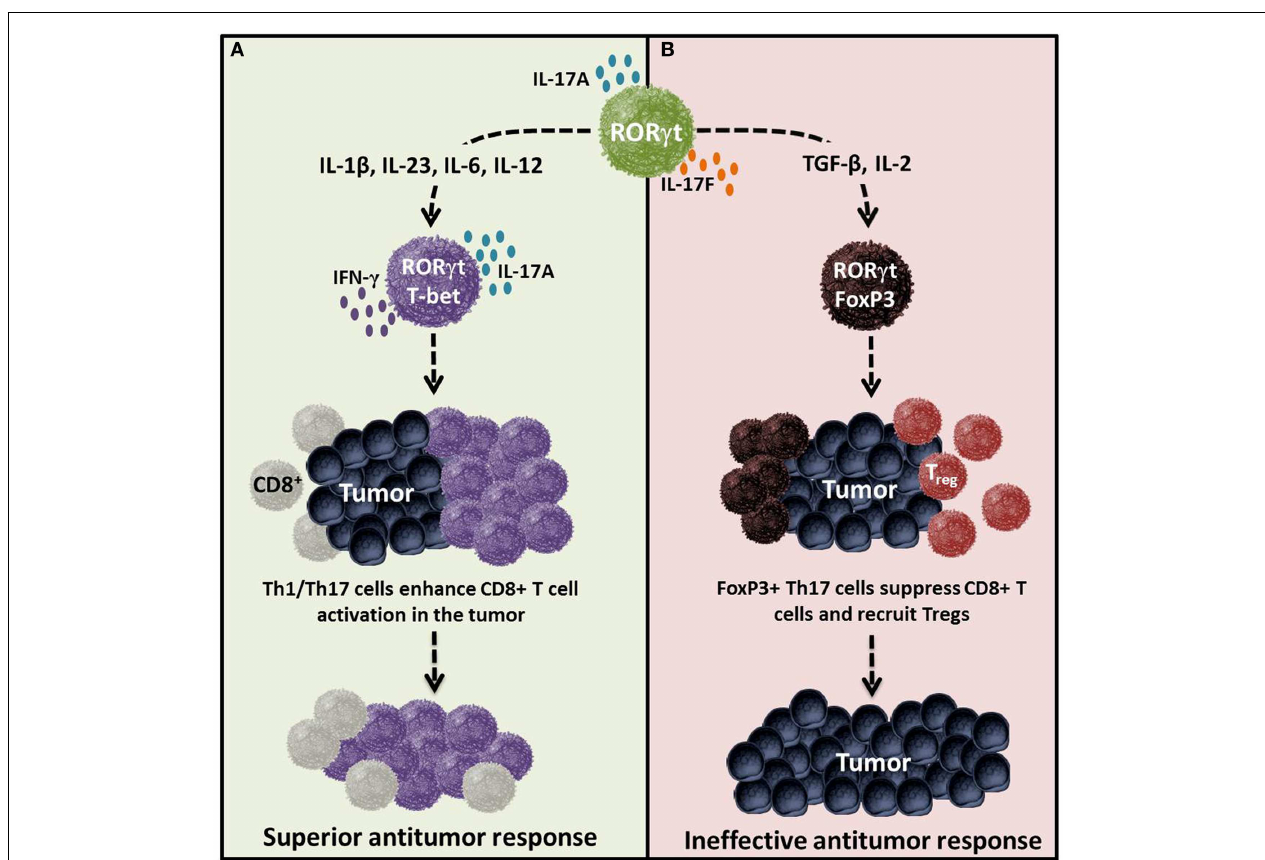
and are capable of mediating potent antitumor immunity. (B) RegulatoryTh17 cells programed with cytokines such asTGF- β , IL-2, and/or CTLA4 can dampen their function and persistence, thereby potentially reducing their capacity to kill tumors. RegulatoryTh17 cells likely do not foster the induction or cooperation of CTLs to the malignant